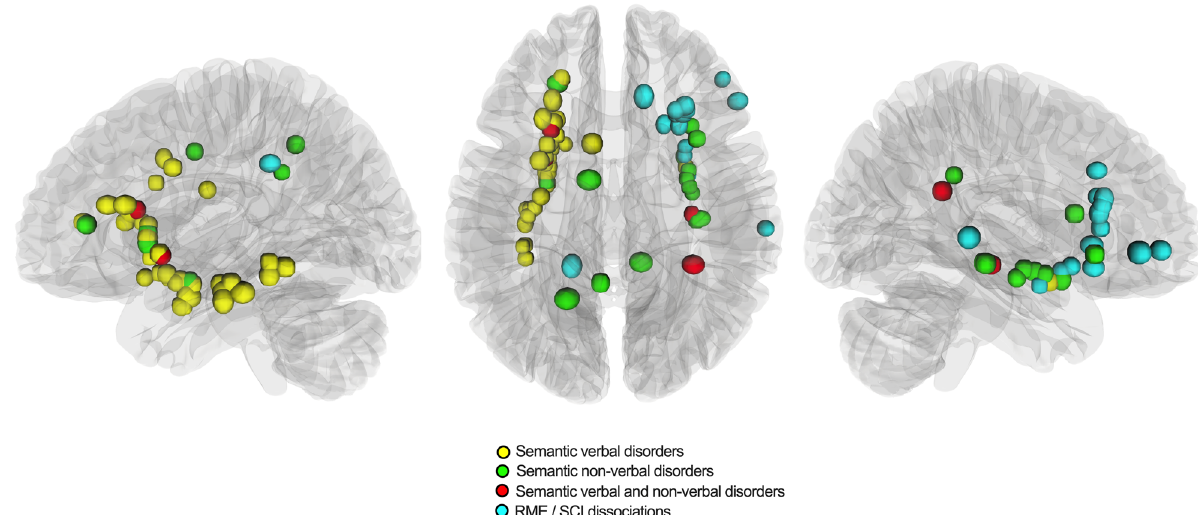
Figure 1. Distribution of cortical and subcortical sites generating self-evaluative disorders. The left part of the figure describes the sites from the left hemisphere (n = 46), the right part of the figure describes the sites from the right hemisphere (n = 28) and the central part of the figure describes all stimulation points, from a superior axial view (n = 74). Yellow circles indicate associated verbal semantic disorders, green circles indicate associated non-verbal semantic disorders, red circles indicate both verbal and non-verbal semantic disorders and cyan circles indicate dissociations between Read the Mind in the Eyes task and the self-confidence index task.